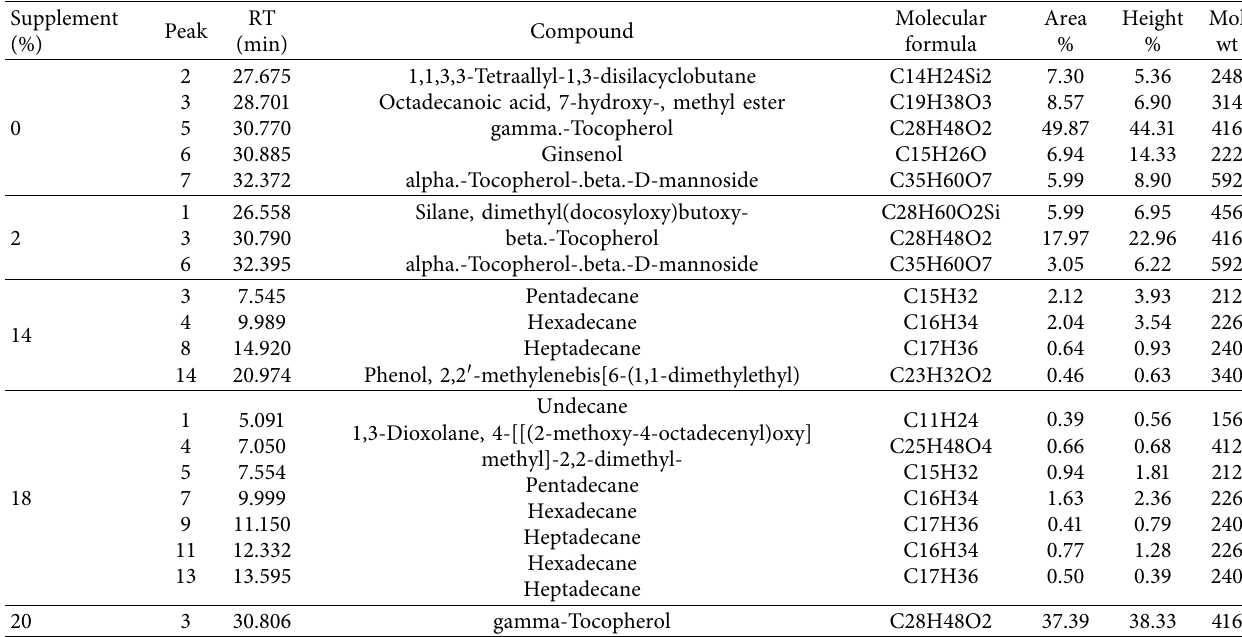
Table 4: GCMS profiling of methanolic extracts of P . ostreatus mushroom grown from sugarcane bagasse substrates supplemented with varying levels of wheat